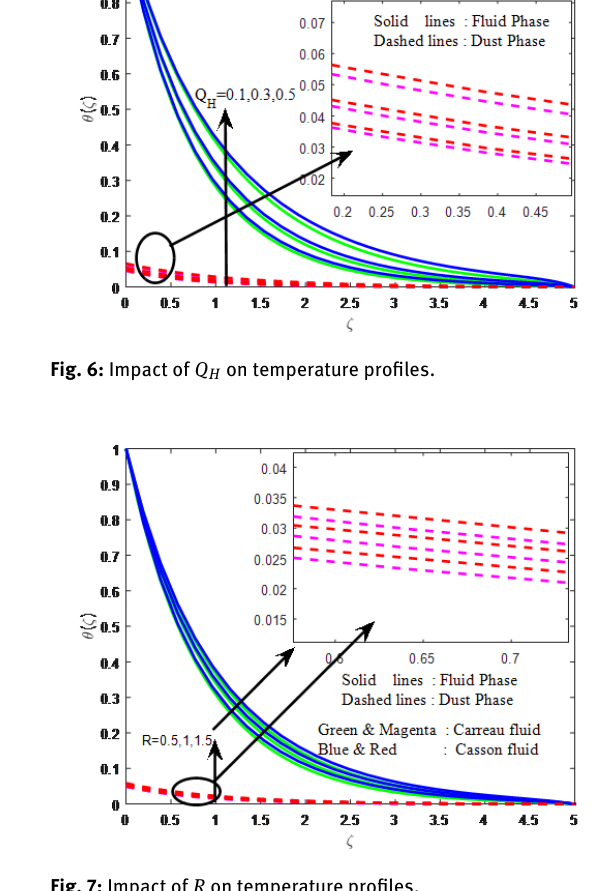
Fig. 4: Impact of ϕ on velocity profiles.